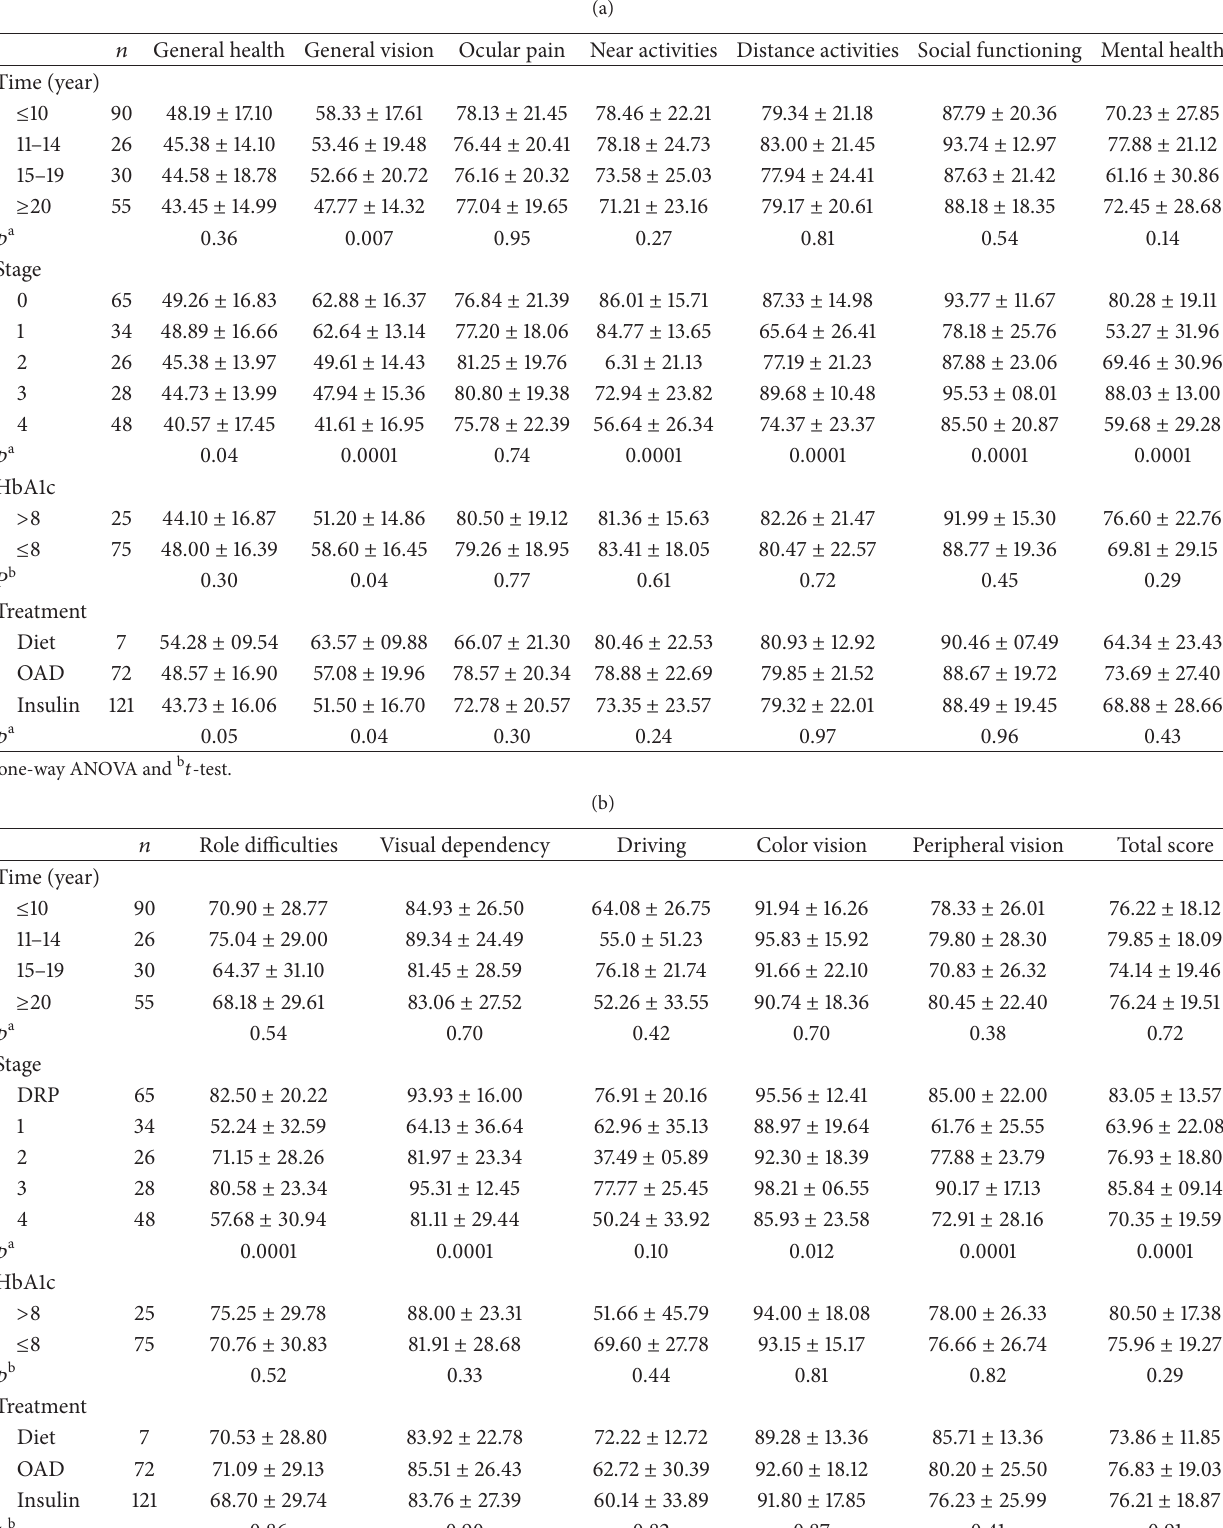
Table 7: Distribution of the questionnaire scores according to clinical characteristics related to